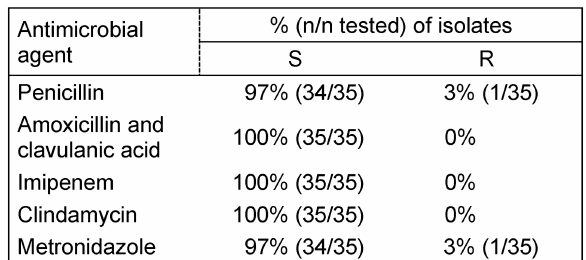
Table 2: Antibiotic susceptibility